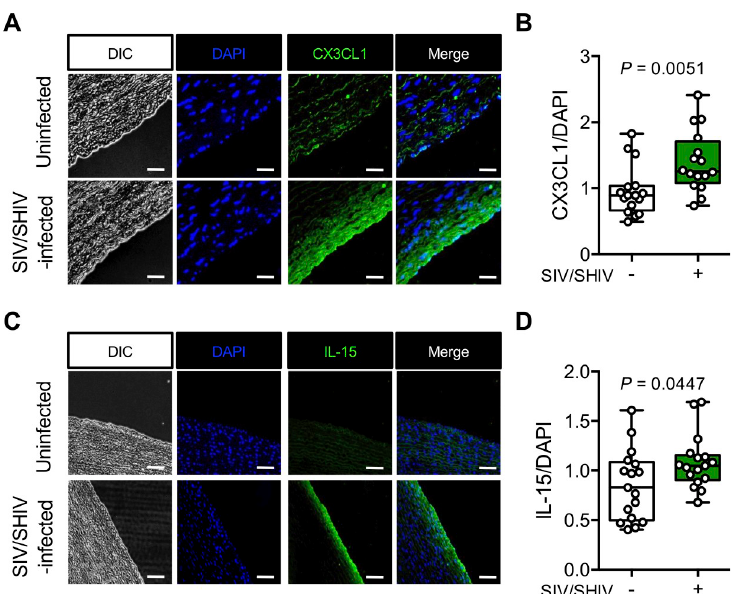
Fig 1. CX3CL1 and IL-15 levels are elevated in aortas from SIV/SHIV-infected RMs. (A,C) Endothelial DAPI and CX3CL1 (A) or IL-15 (C) levels in uninfected controls (n = 16; upper row) and from SIV/SHIV-infected RMs (n = 16; lower row). (B,D) Ratio of CX3CL1 (B) or IL-15 (D) fluorescence to DAPI fluorescence per animal (n = 16), calculated from ~300 RM aortic endothelial cells per sample. Differences between groups were determined by Mann-Whitney U test. DIC, differential interference